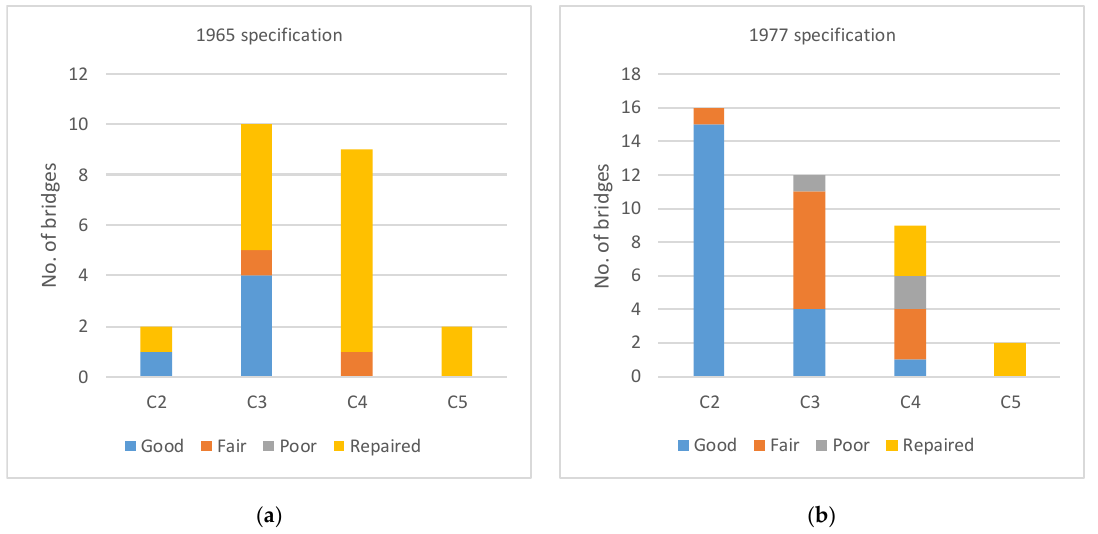
Figure 3. The summary of coating condition for the two specifications as a function of corrosivity: ( a ) 1965 specification; ( b ) 1977 specification.